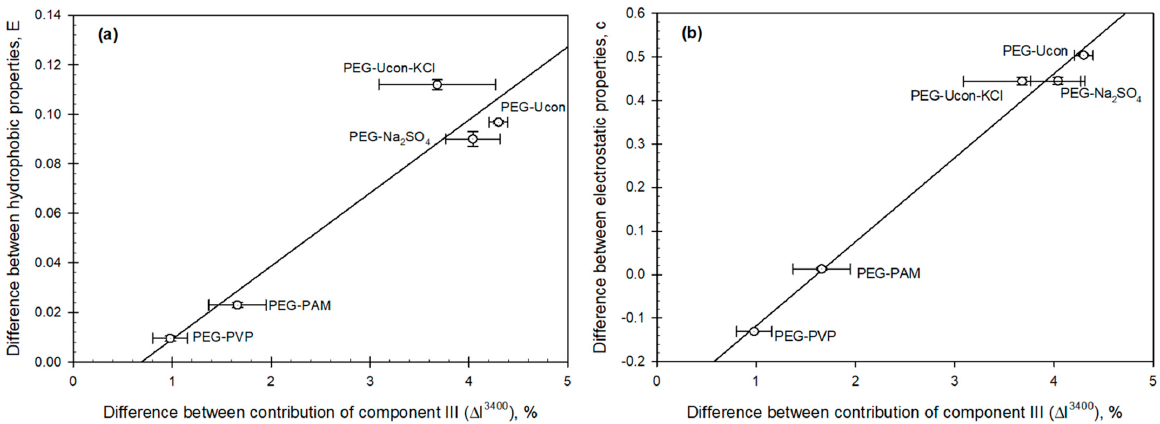
Figure 8. Difference between ( a ) hydrophobic properties (parameter E) of the phases and ( b ) electrostatic properties (parameter c) as a function of the difference between contributions of Gaussian component III in the OH − stretch band of water in the coexisting phases ( Δ I 3400 cm − 1 ) of the aqueous two-phase systems indicated (parameters E and c as defined in Equation (1)).